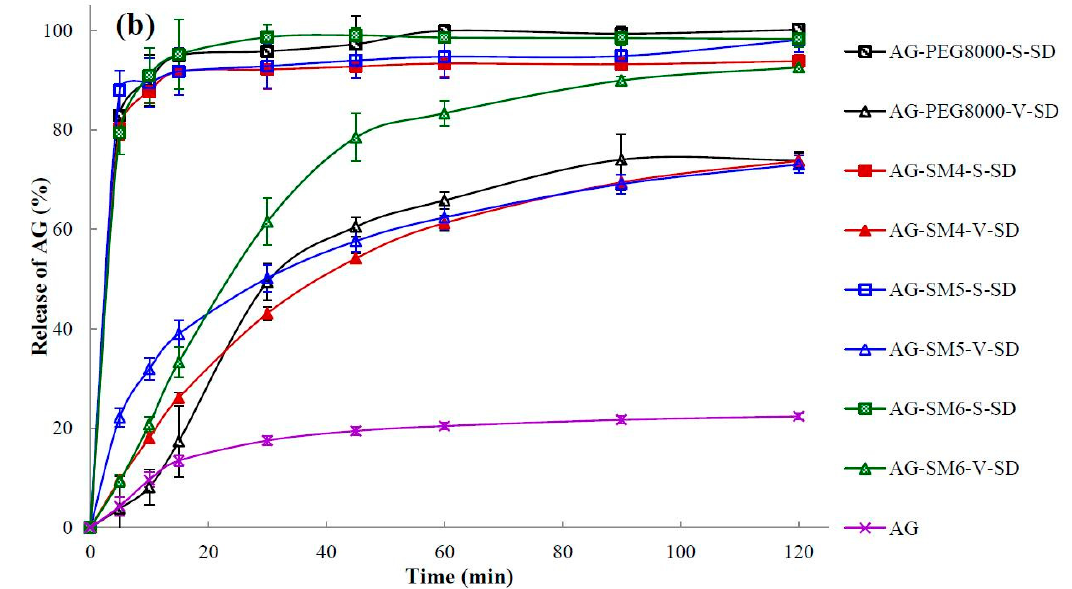
Figure 7. Dissolution profiles of pure andrographolide (AG) and solid dispersions (SD): ( a ) PEG4000, SM1, SM2, and SM3 as carrier materials, ( b ) PEG8000, SM4, SM5, and SM6 as carrier materials ( n = 6). Table 4. Q 5min and t 85% of pure andrographolide (AG), physical mixtures (PM), and solid dispersions (SD).